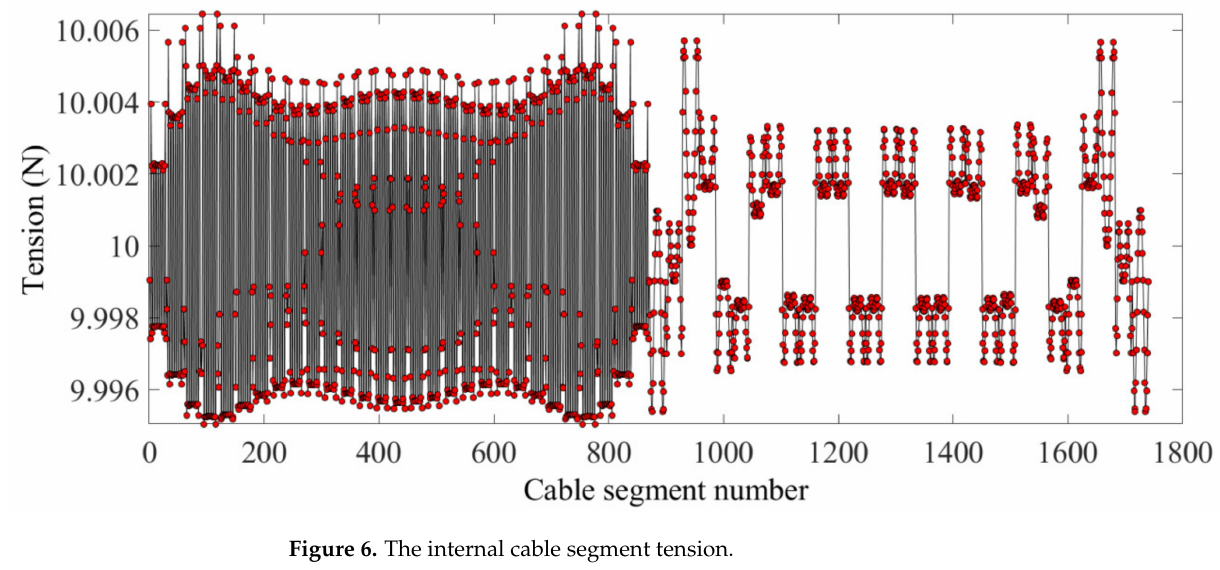
Figure 6. The internal cable segment tension.